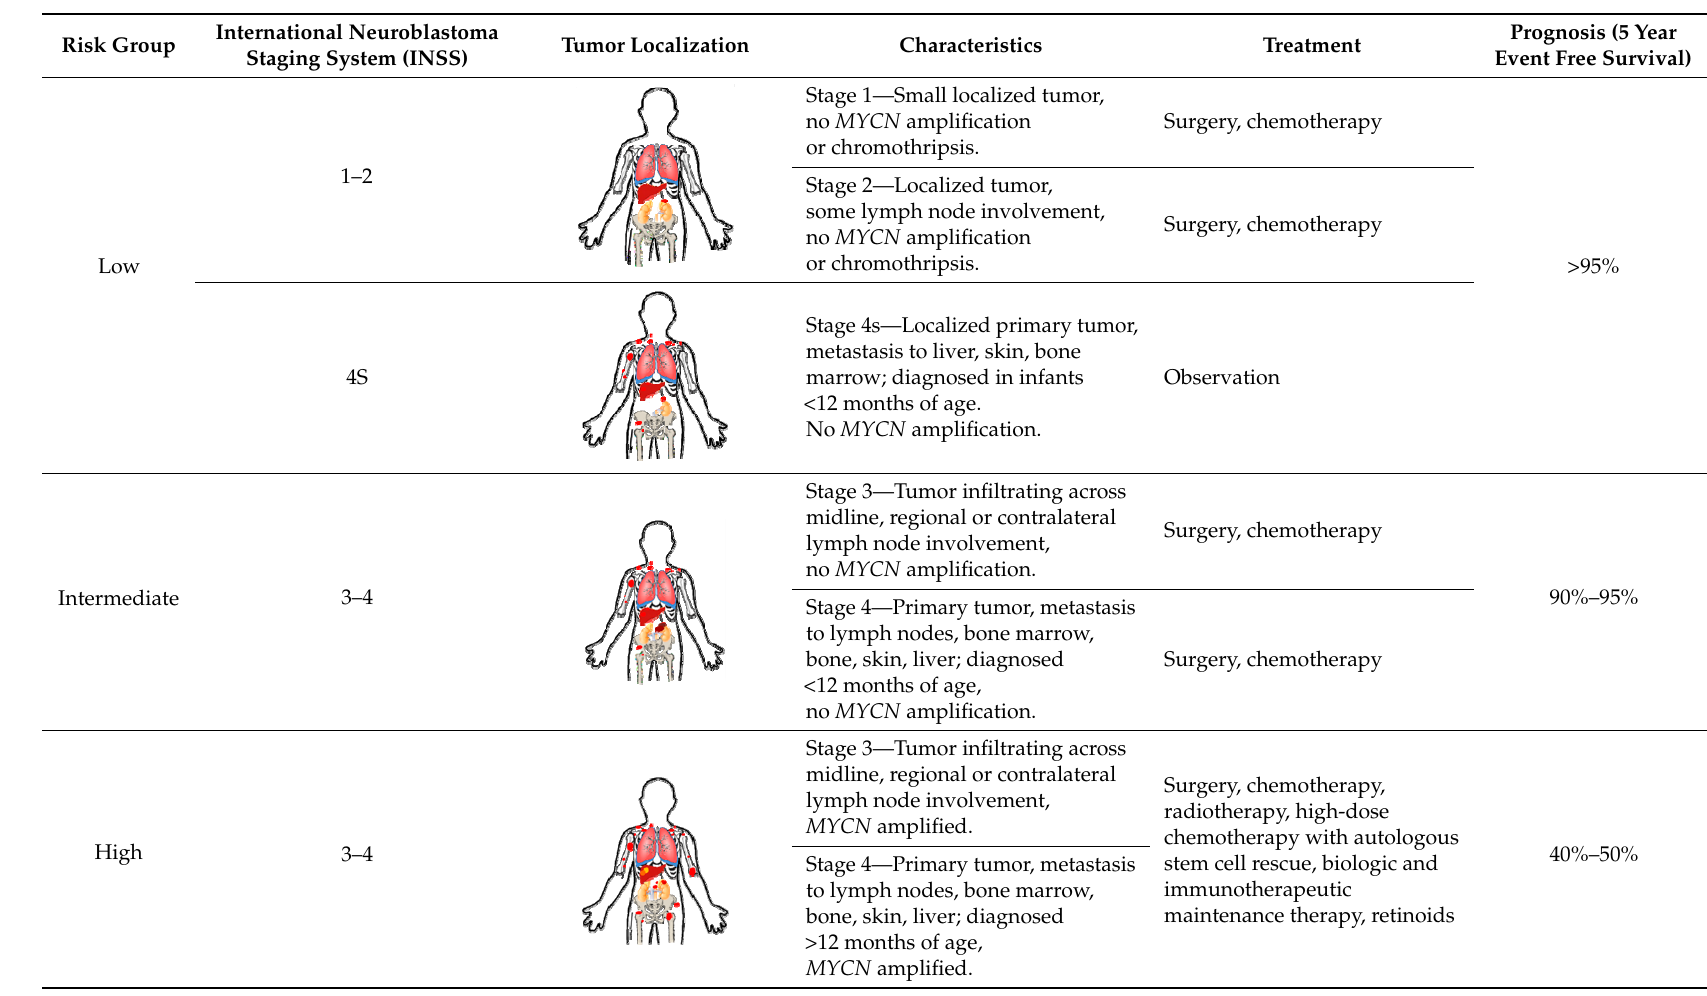
Table 1. Treatment and prognosis of neuroblastoma patients by risk group and staging. Prognosis is 5-year event-free survival [3,9,11,15,17]. MYCN: V-Myc avian myelocytomatosis viral oncogene neuroblastoma derived homolog.